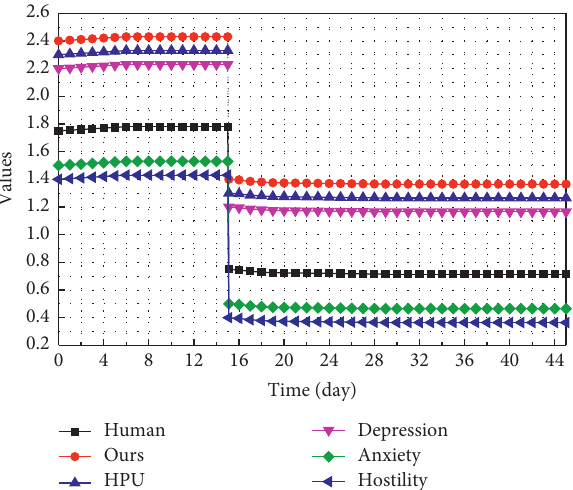
Figure 10: Comparison of the results of the